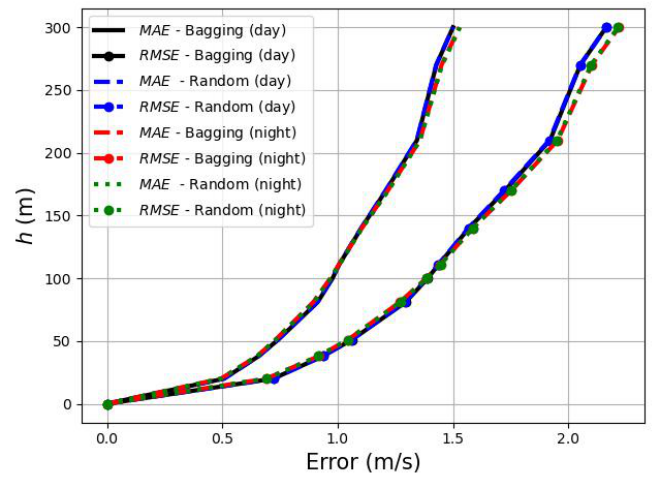
Figure 6. Averaged errors during day and night. The bagging and the random forest regressors obtained similar results.